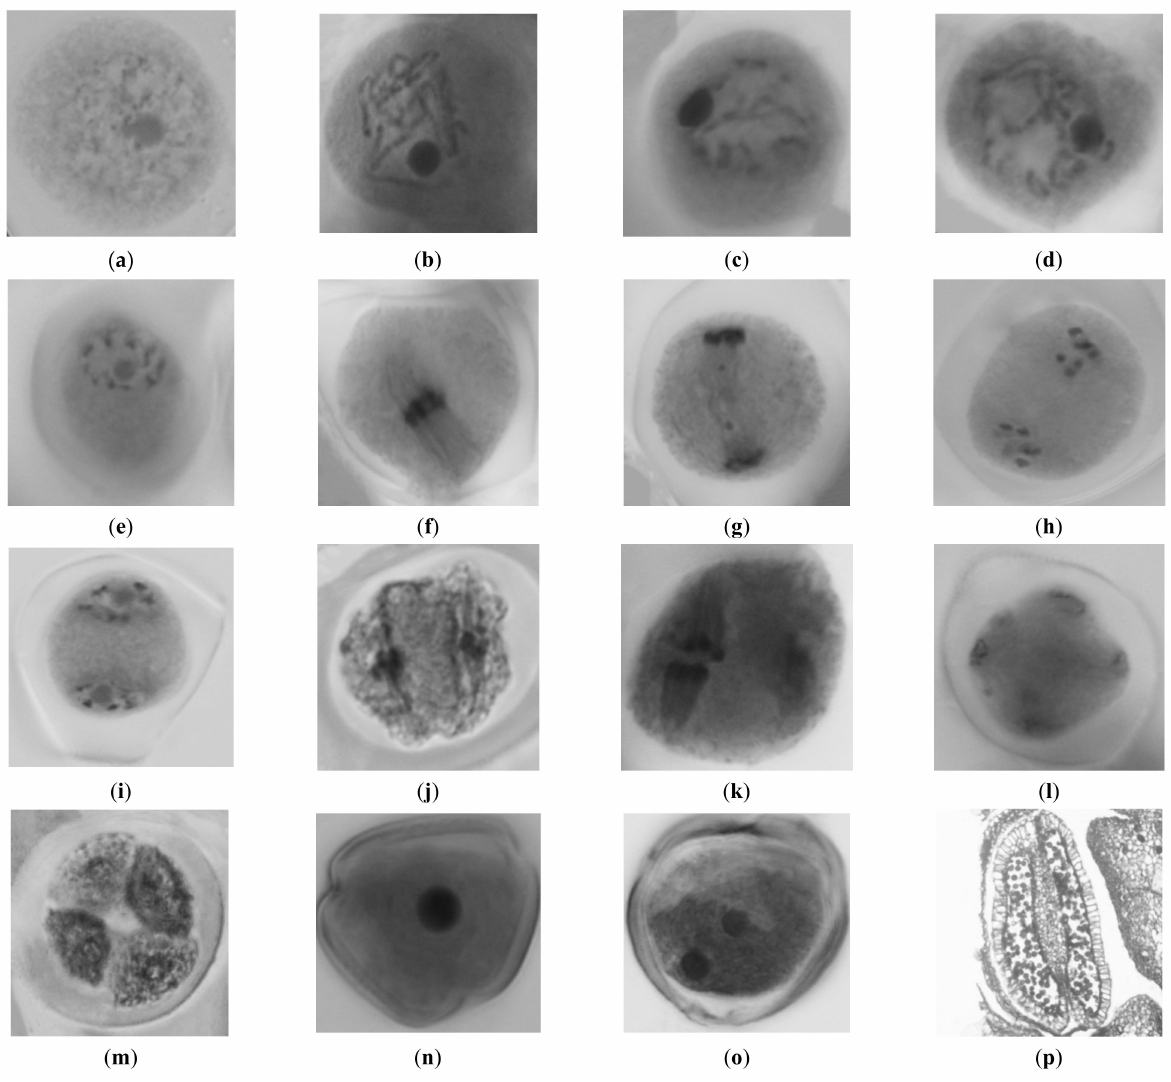
Figure 2. Microsporogenesis and development of male gametophytes ( a – o scale bar = 5 µ m; p scale bar = 50 µ m). ( a ) leptotene; ( b ) zygotene; ( c ) pacthytene; ( d ) diplotene; ( e ) diakinesis; ( f ) metaphase I; ( g ) anaphase I; ( h ) telophase I; ( i ) prophase II; ( j ) metaphase II; ( k ) anaphase II; ( l ) telophase II: ( m ) tetrad stage (tertrahedroid); ( n ) slope nucleus centered; ( o ) dikaryophase; ( p ) matured pollen